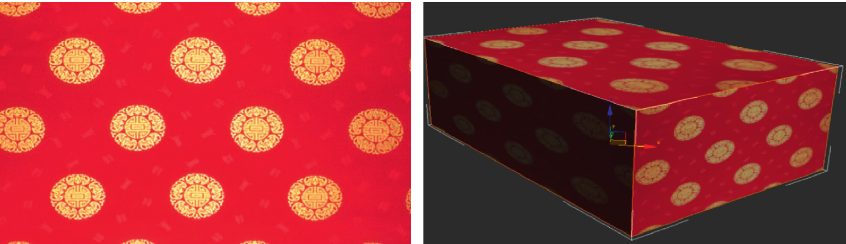
Figure 10: UVW map chartlet.